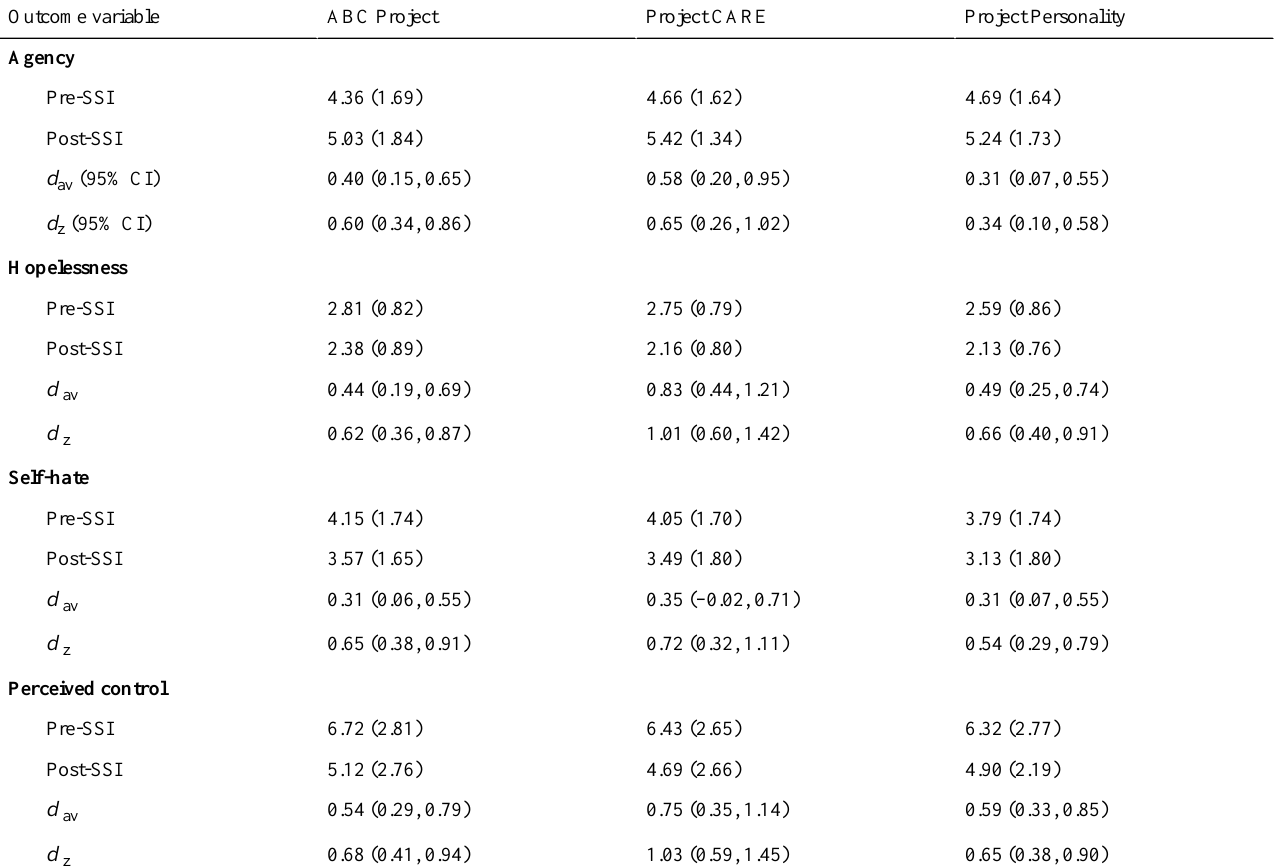
Table 4. Means, standard deviations, and effect sizes by selected SSI; mean (SD) or (95%